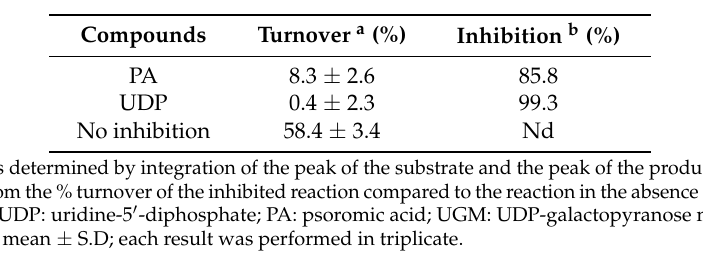
Table 3. Inhibitory activities of PA and UDP against UGM.